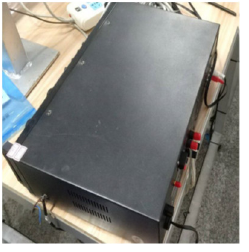
Figure 4. Signal enhancement device.